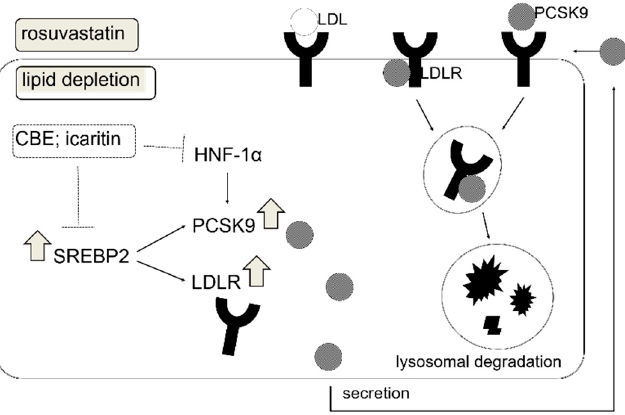
Figure 6. Schematic overview of cellular regulation of PCSK9 and LDLR by rosuvastatin and CBE and its active compound icaritin in lipid deficient conditions. Among the CBE components, icaritin increases LDLR by inhibiting PCSK9 via suppression of transcriptional activation of SREBP2 and HNF-1 α